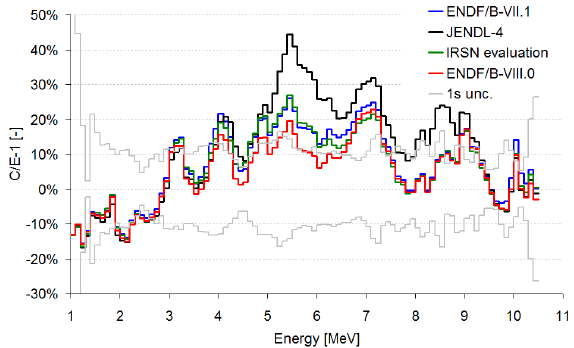
Figure 4. C / E-1 for various libraries determined leakage flux of AmBe source in a heavy water sphere of diameter 50 cm.